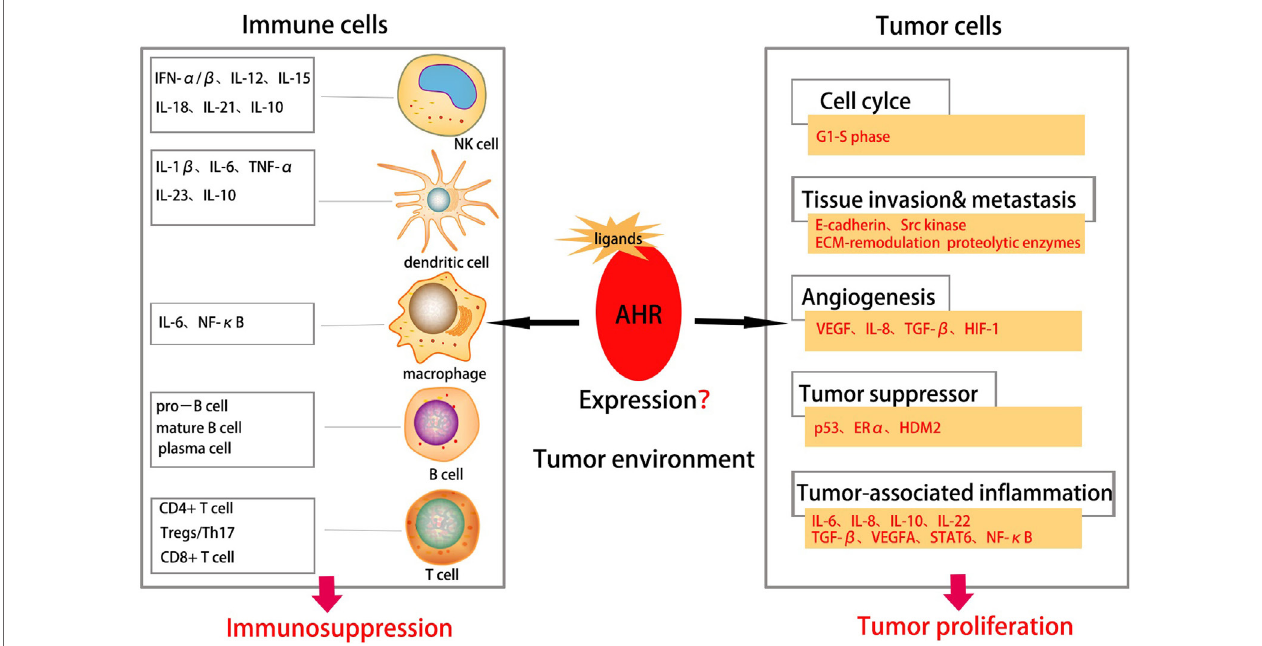
FigURe 3 | Aryl hydrocarbon receptor (AhR) in tumor environment. Abnormal expression of AhR in tumor environment affects both the immune cells and tumor cells in tumor environment. The AhR plays an important role in various stages of tumorigenesis, including cell proliferation, tissue invasion, angiogenesis, tumor- associated inflammation, metastasis etc., suggesting AhR as a promoter for tumor initiation. It can also suppress proliferation and function of immune cells thus suppressing tumor immune